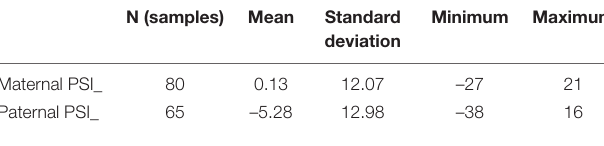
TABLE 4 | Negligence: Mean perception of parental style (PSI). N (samples) Mean Standard